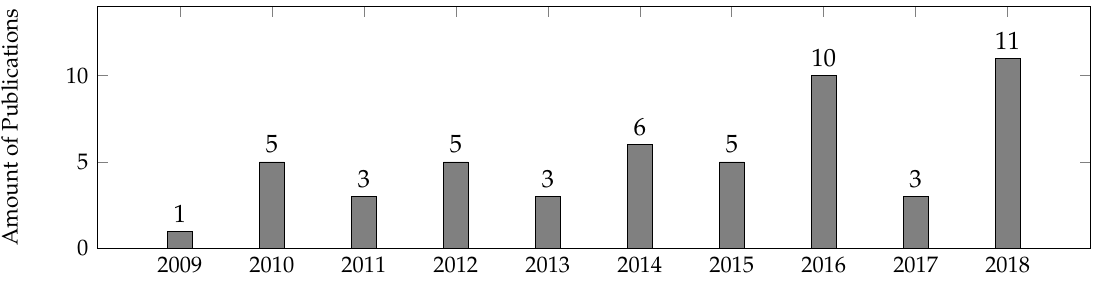
Figure 3. Papers distribution by year of